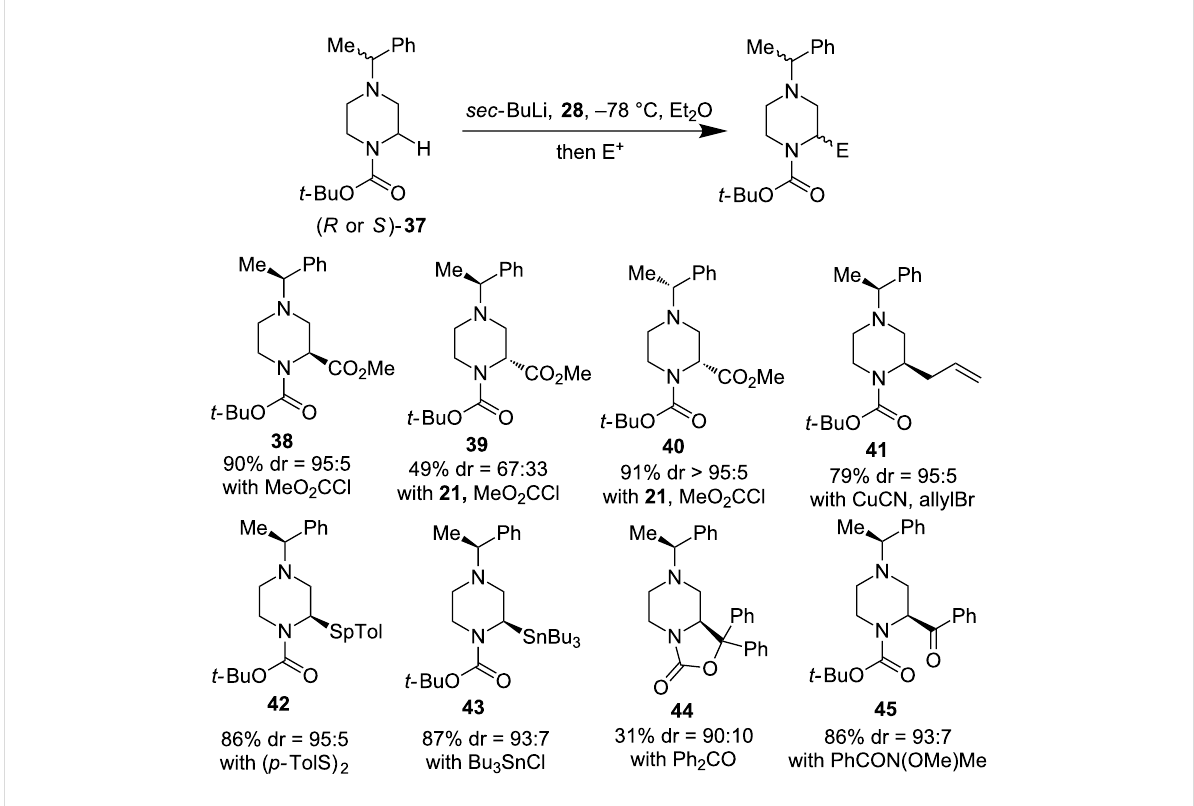
Figure 10: A “chiral auxiliary” strategy toward enantiopure α -functionalized piperazines by O’Brien et al. 2016